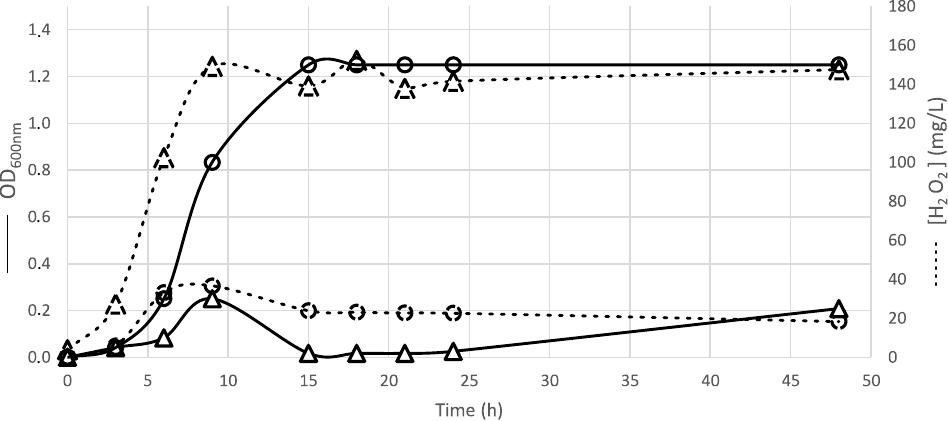
Figure 6. Assessment of H 2 O 2 production during the growth of Carnobacteriun inhibens MIP2551 (triangle) and Lactococcus garvieae CIP102507 (circle). Dashed lines: H 2 O 2 concentration estimated by Dosatest ® Peroxide test strips; Solid lines: OD measured at 600 nm. Strains were cultivated at 26 ◦ C, in brain heart infusion (BHI) medium and in shaking